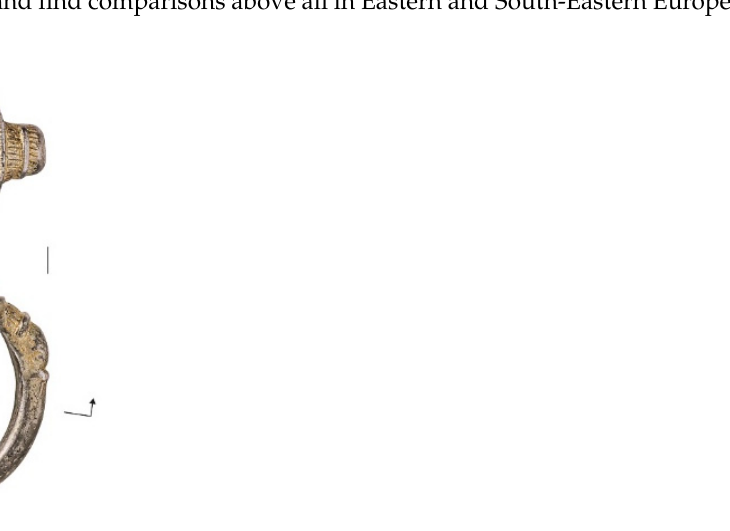
Figure 2. Treasure from Wiener Neustadt. Finger ring with “eagle” motif, 13th/14th century. Photo: Paul Kolp; editing: Franz Siegmeth.